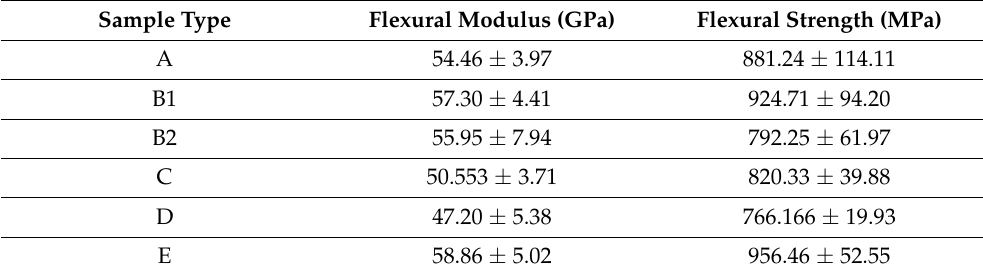
Table 4. Flexural strength and modulus for interlayer toughened carbon fibre.